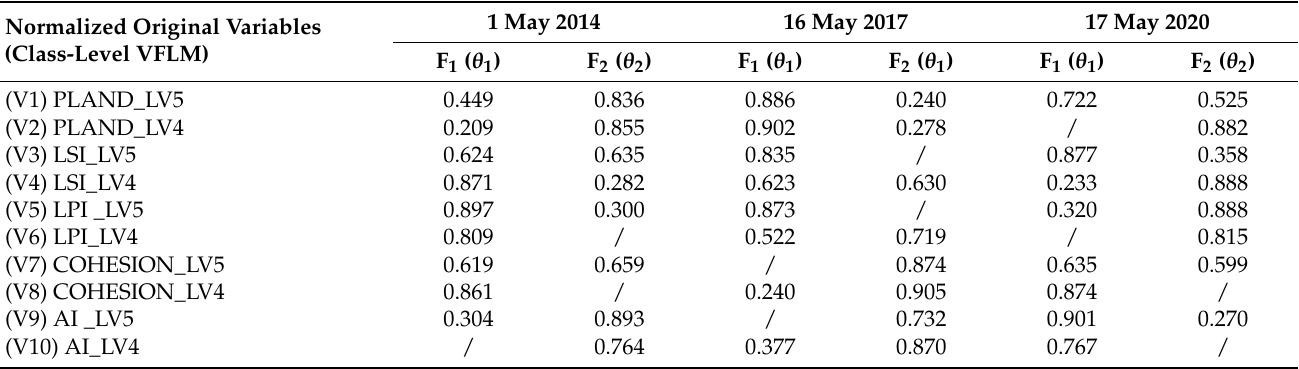
Table 7. Component matrix of principal component analysis (PCA) 1 (cid:13) .